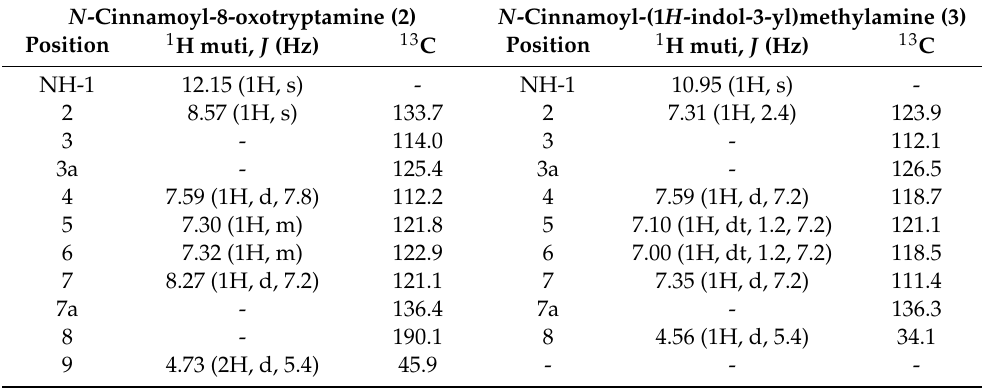
Table 1. 1 H (600 MHz) and 13 C (150 MHz) NMR spectral data for 2 and 3 (in DMSO- d 6